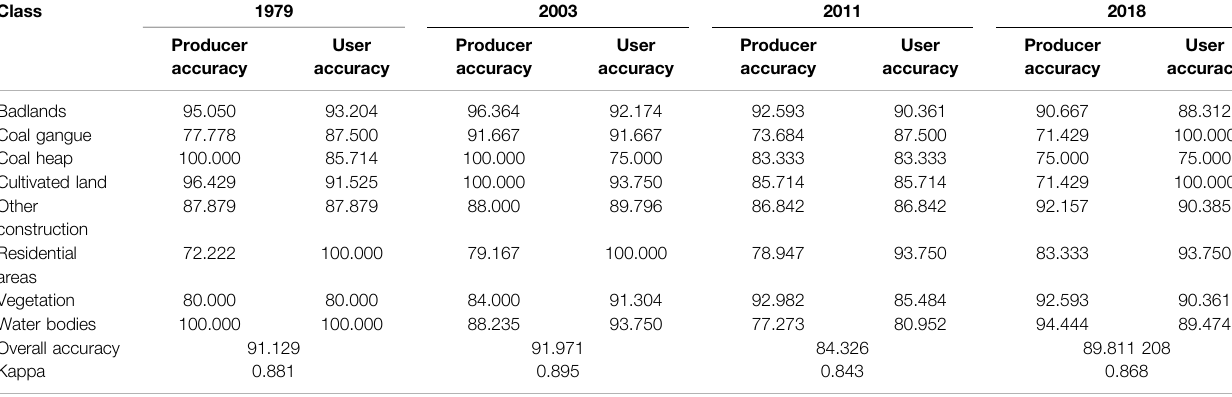
TABLE 4 | Accuracy assessment for the interpretation maps from 1979 to 2018 (unit: %). Class